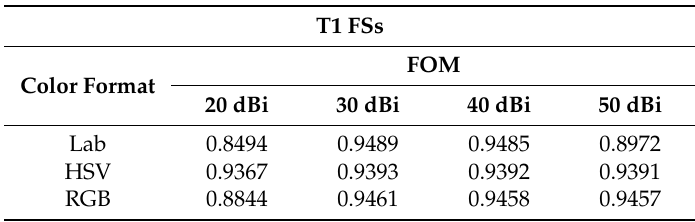
Table 7. FOM values achieved by T1 FSs in images with Gaussian noise.